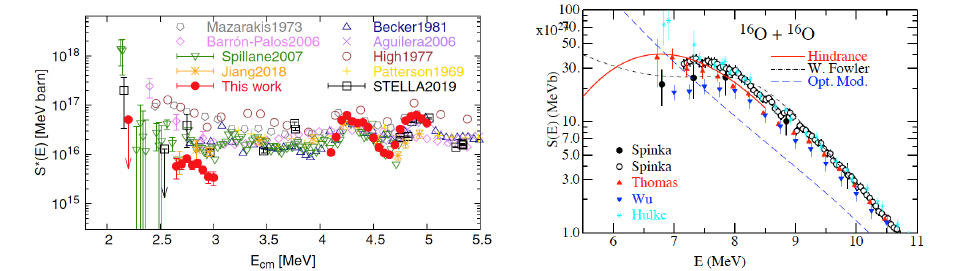
Figure 2. S factor measured by Tan (red symbols [7]) and by other groups for 12 C + 12 C (left) and for 16 O + 16 O (right) [3], compared to several calculations.